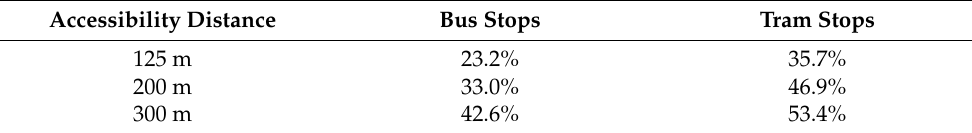
Table 2. Proximity of PT to Bike